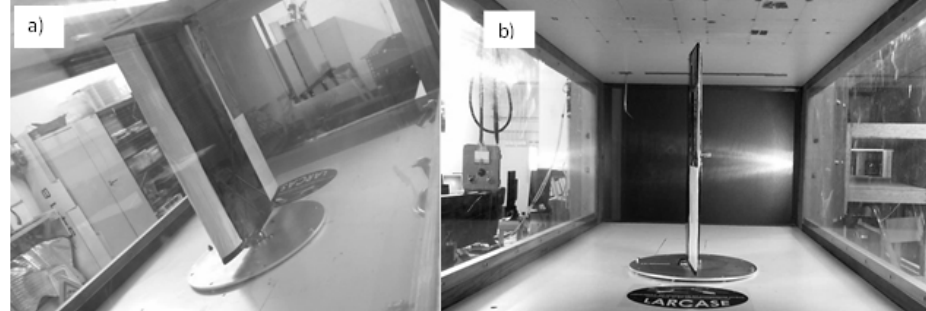
Figure 19. Adaptive wing prototype experimental tests: ( a ) side view and ( b ) back view.